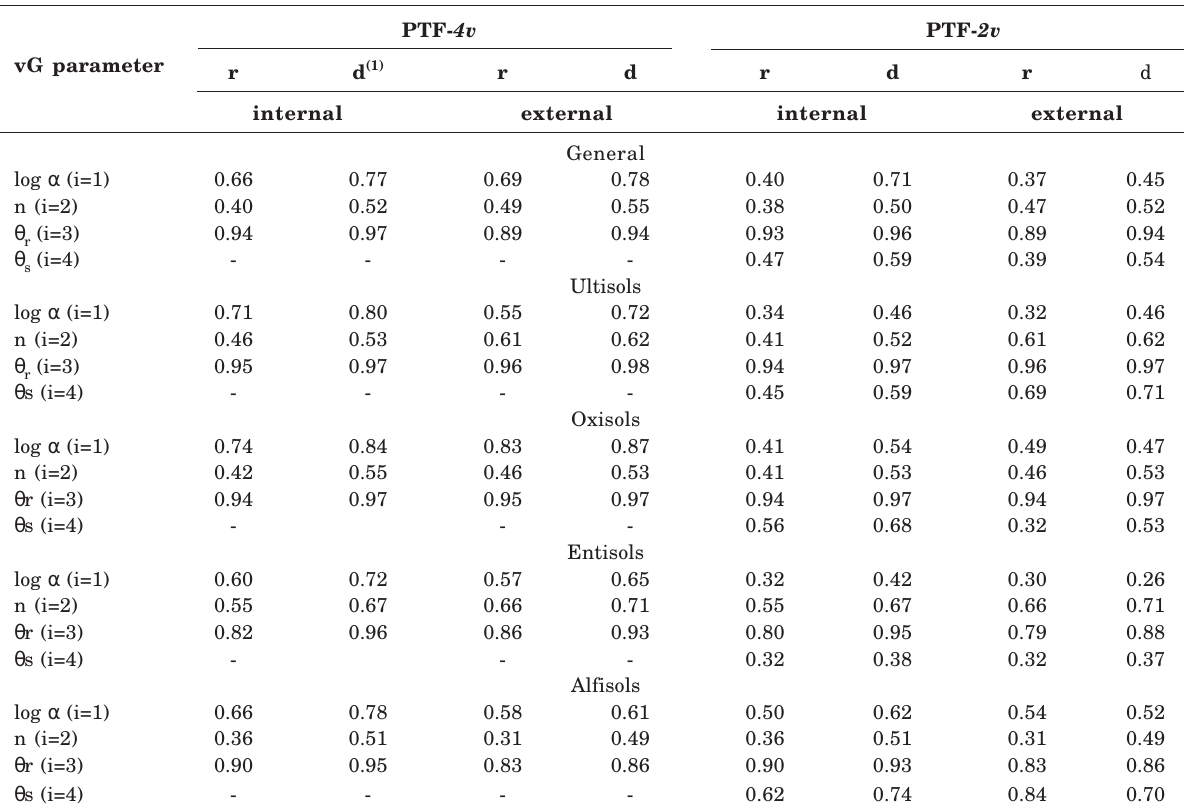
Table 6. Statistical performance (correlation coefficient, r and index of agreement, d for general PTFs as well as for soil-class-specific PTFs for each VG parameter (internal validation: development subset, N = 673; external validation: validation subset, N = 113)